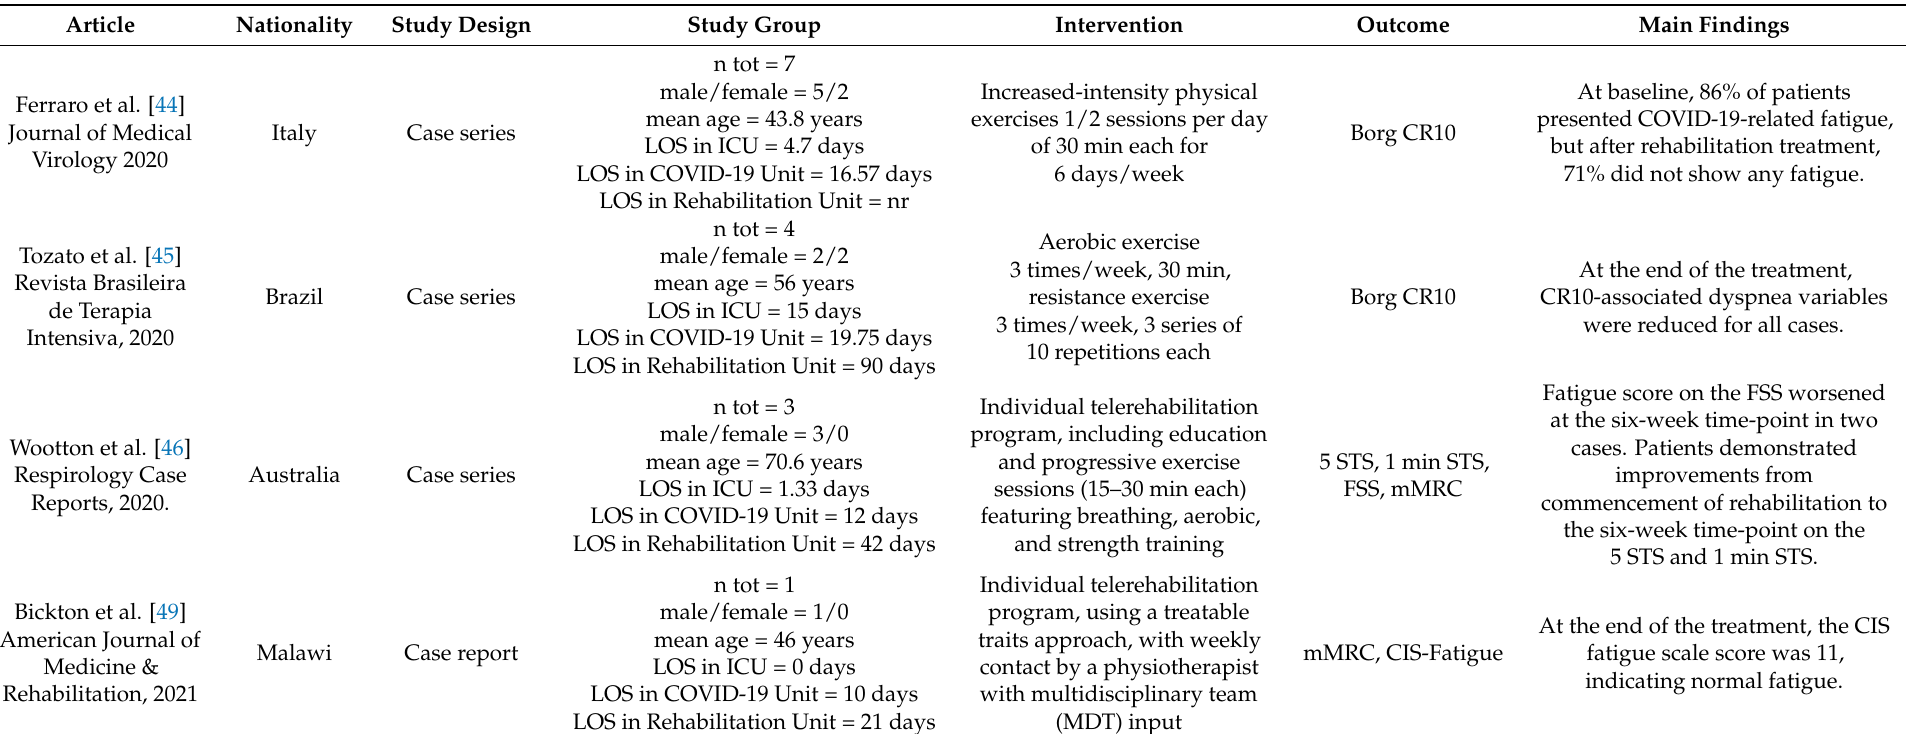
Table 3. Main findings of the included studies (case report and case